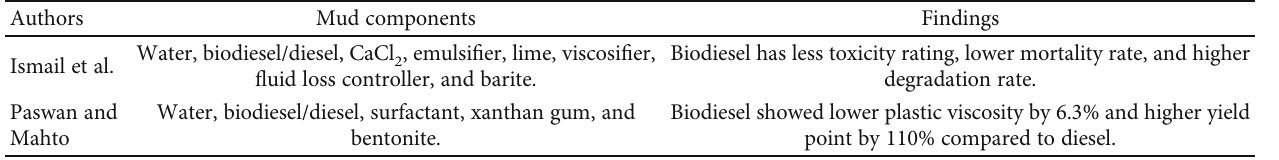
Table 2: Mud components and fi ndings of biodiesel in water emulsion mud studies. Mud components Findings Biodiesel has less toxicity rating, lower mortality rate, and higher degradation